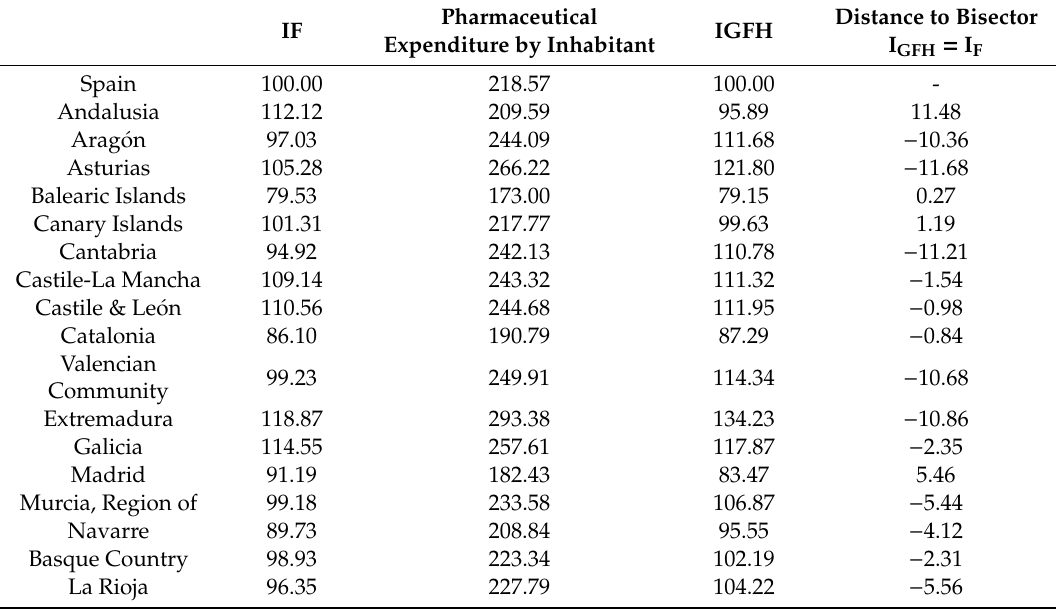
Table 5. Indices IF, Pharmaceutical Expenditure by Inhabitant, IGFH.